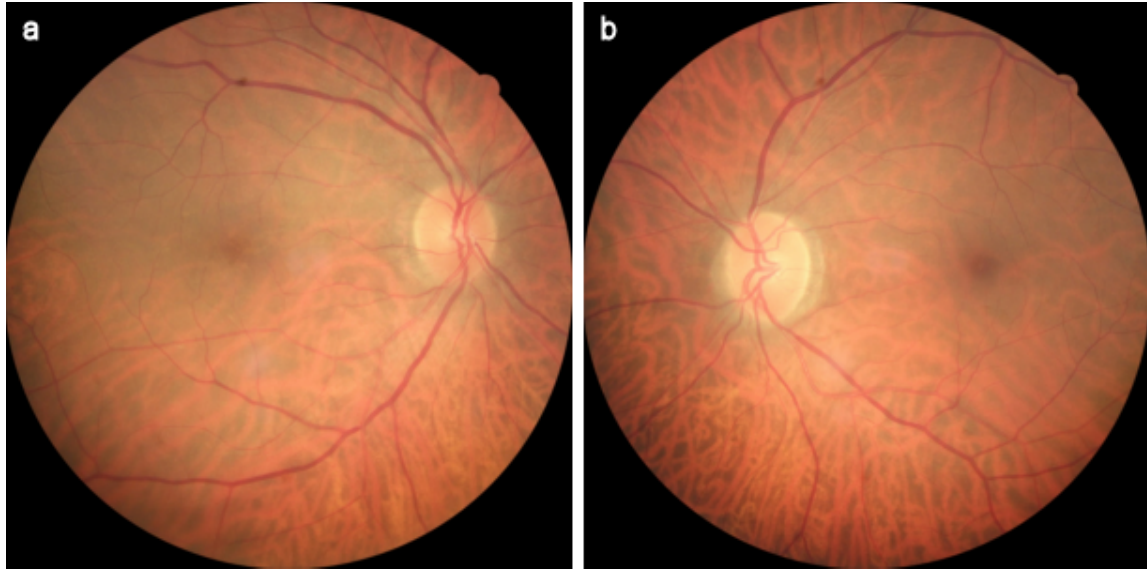
Figure 6: Fundus images at 2-week examination after the treatment (a) The retinal lesion with the annular ring of yellowish reflex disappeared on the color fundus image of the right eye, (b) view of left fundus